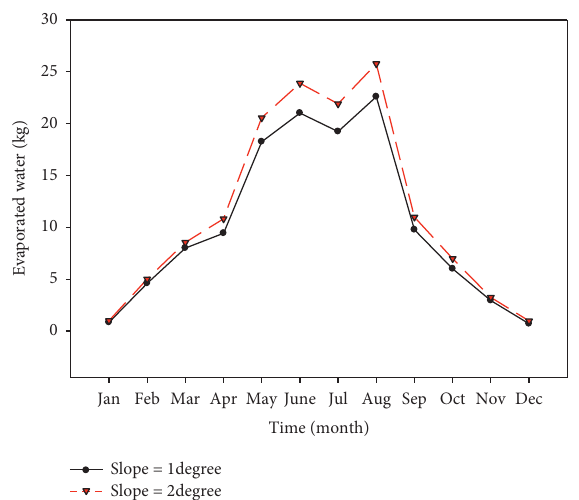
Figure 15: Effect of the inclination angle of the reactor on monthly evaporated water at. Re � 9000, water depth � 5.6mm, and aspect ratio � 180.